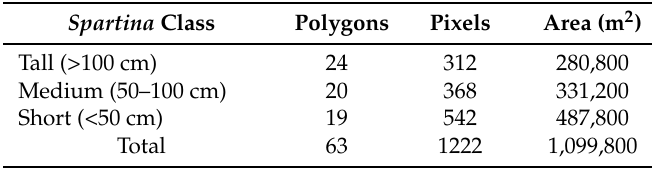
Table 3. ENVI’s Region of Interest (ROI) tool was used to extract polygons across the three height classes of S. alterniflora . The table depicts number of polygons, total pixels, and area covered by each of the three height classes of S. alterniflora sampled for this analysis.